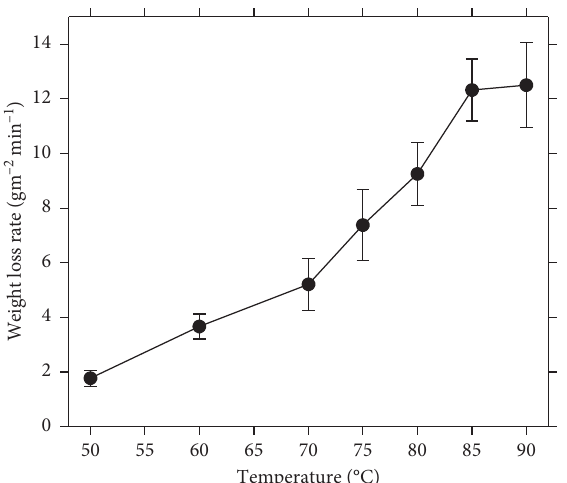
Figure 6: The static pickling rate of the specimen in 300gL − 1 H